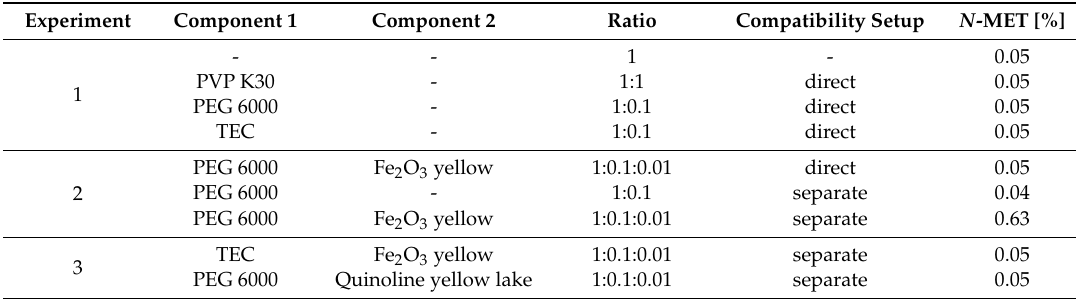
Table 3. Origin of reactive impurities in the tablet formulation. Paroxetine hydrochloride (200 mg) alone or mixed with components from formulation was weighed into glass vials in ratios defined in the table (first value indicates drug substance, second component 1 and third component 2) and sealed. Mixtures of excipient components are in direct contact or separate from the drug substance (compatibility setup). The N -methyl paroxetine ( N -MET) percentage (%) presents the area % of the determined impurity after seven days at 60 ◦